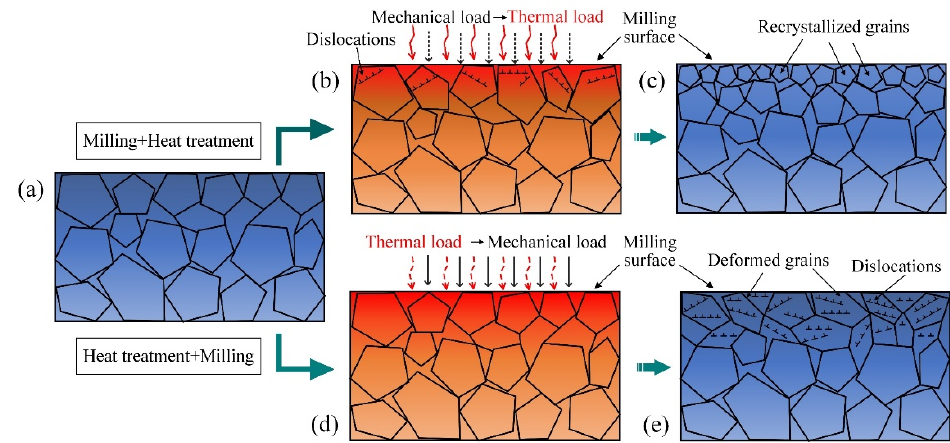
Figure 8. Schematic diagram of microstructure evolution of the machined workpiece surface by sequential production process: ( a ) original equiaxed grained microstructure; ( b ) a small number of dislocations formed within grains due to milling; ( c ) recrystallized grains without dislocations formed on the milling surface after the M + HT process; ( d ) original grains’ growth due to heat treatment; ( e ) elongated grains with a large number of dislocations formed on the surface after the HT + M